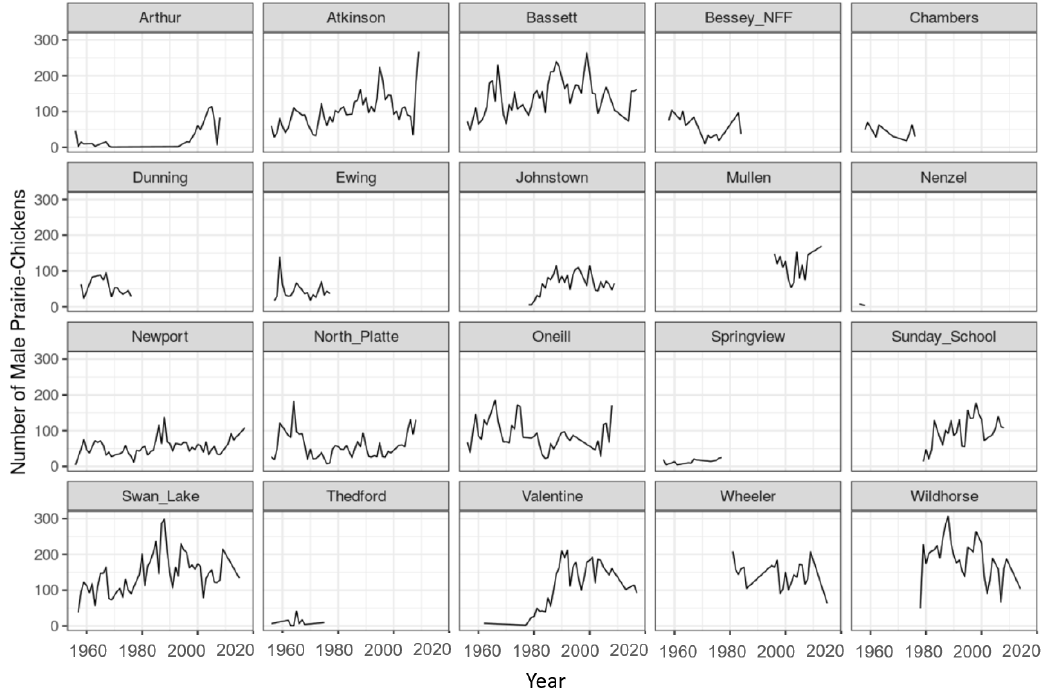
Figure A2. Prairie-chicken spring breeding ground counts by 20-mile route from 1956 to 2018 for 20 historical survey transects in the Sandhills of Nebraska, USA.